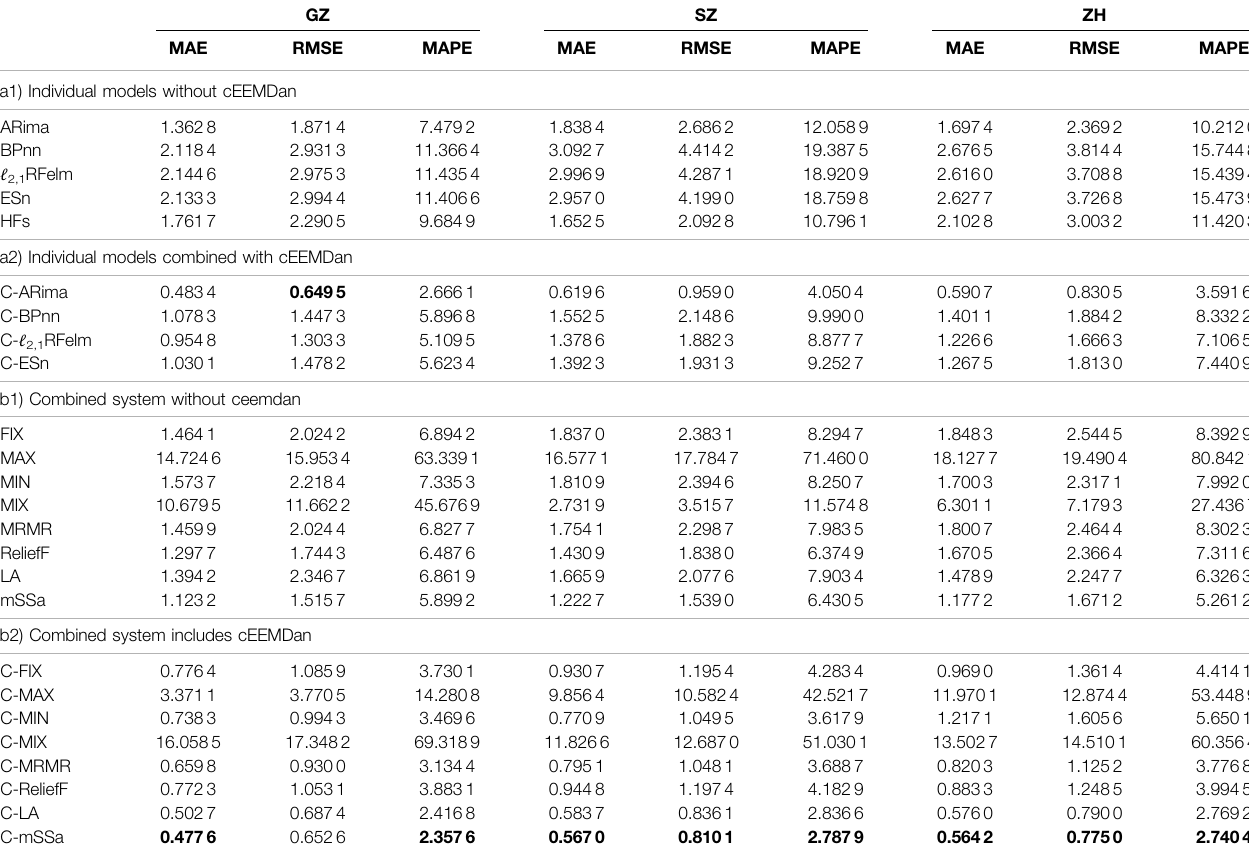
TABLE 6 | Forecasting results of individual models and combined systems based on the original data and decomposed data. GZ SZ ZH MAE RMSE MAPE MAE RMSE MAPE MAE RMSE